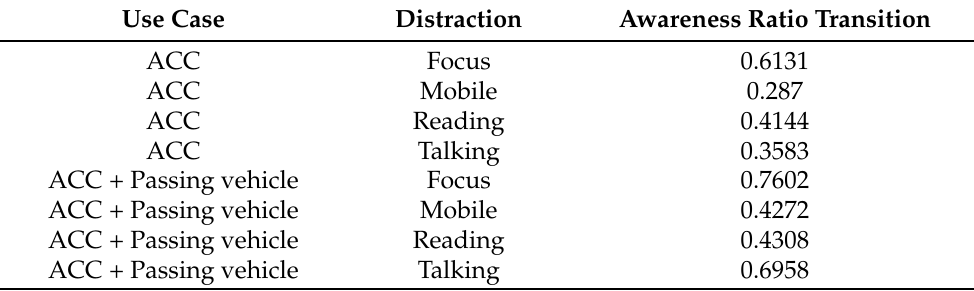
Table 5. Situation-awareness ratio for the different experiments